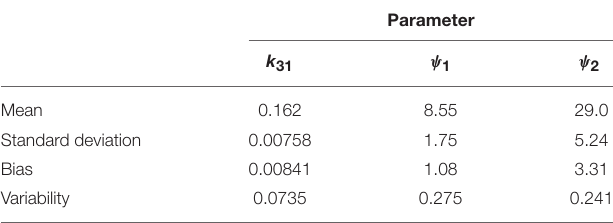
TABLE 6 | Mean, standard deviation, bias, and variability of the estimates of k 31 , ψ 1 , and ψ 2